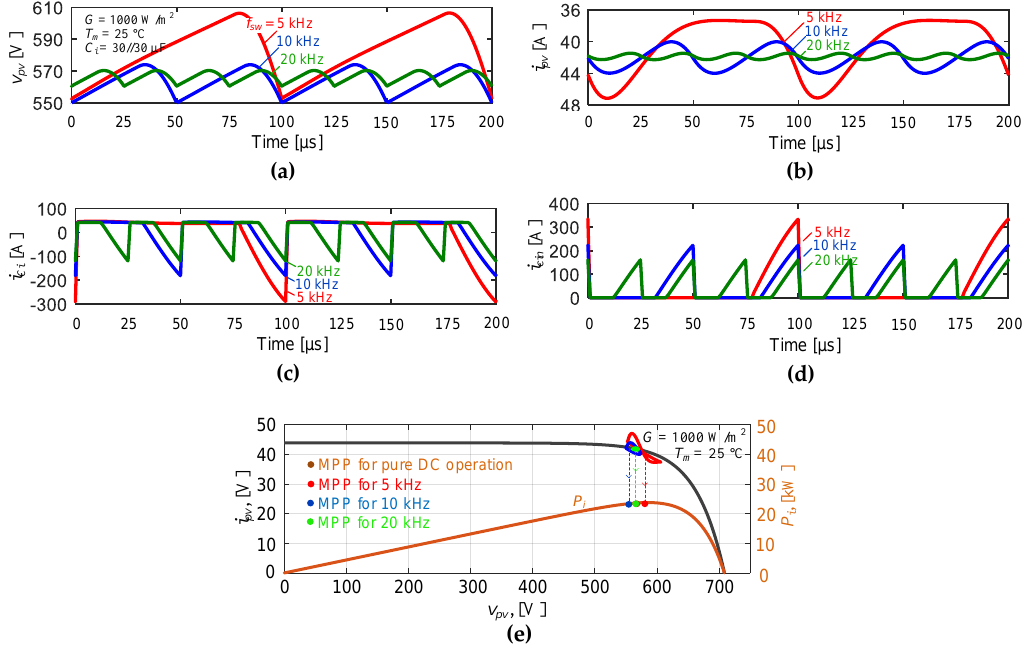
Figure 14. Variations in ripple content for different switching frequencies, f sw : ( a ) PV panel voltage, v pv ; ( b ) PV panel current, i pv ; ( c ) input capacitor current, i Ci ; ( d ) total current transferred to MPPT converter; i cin , and ( e ) effects of f sw on maximum power point of multi-string PV system in steady-state.